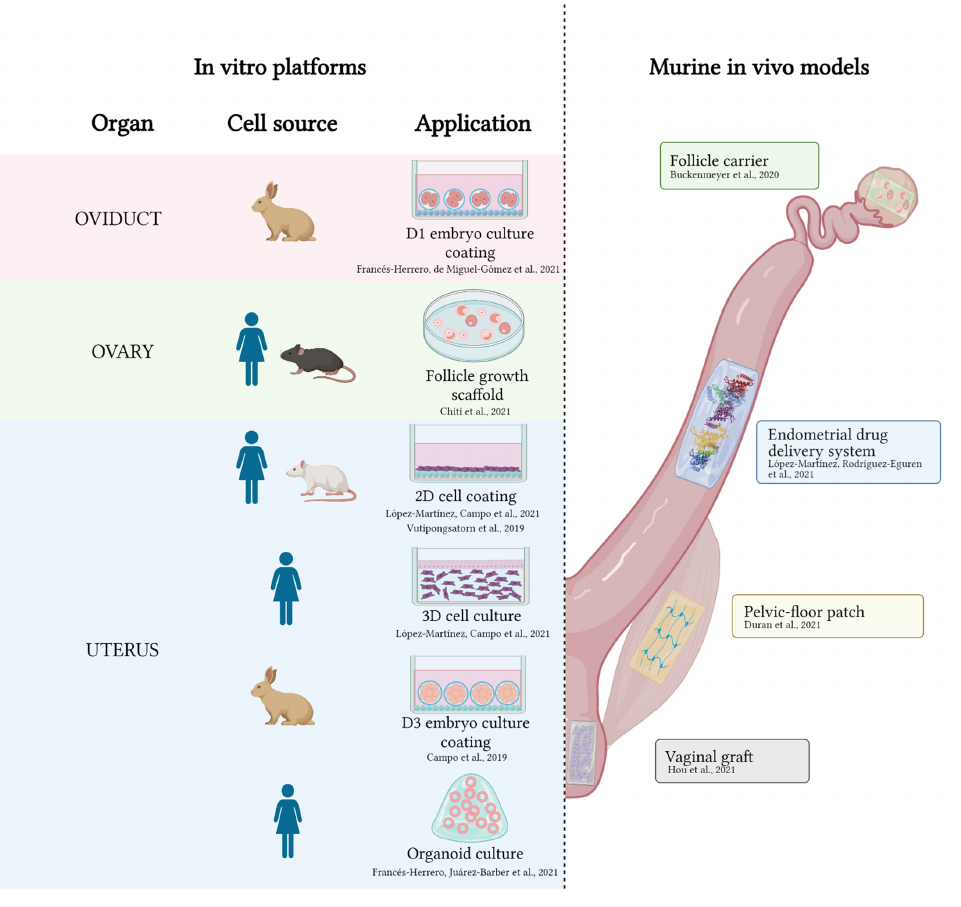
Figure 2. Applications of decellularized ECM hydrogels in the female reproductive tract. On the left, in vitro platforms involving ECM hydrogels from oviducts, ovary, and uterus. On the right, in vivo models where ECM hydrogels have been applied. References are indicated adjacent to each application [40,52,106–111,117,118]. Created with Biorender.com.